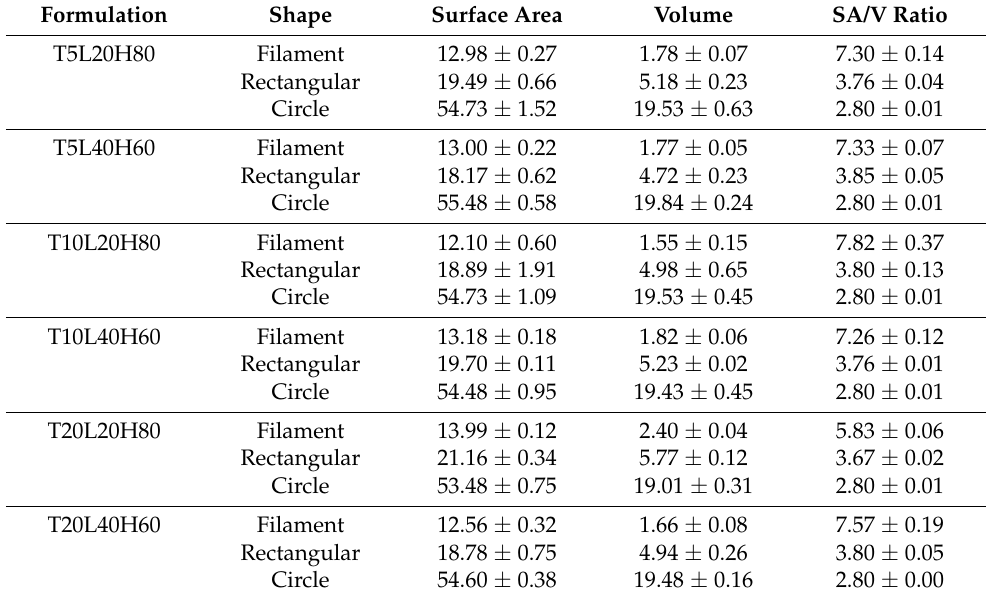
Table 2. Surface area, volume, and SA/V ratio of PCL implants.